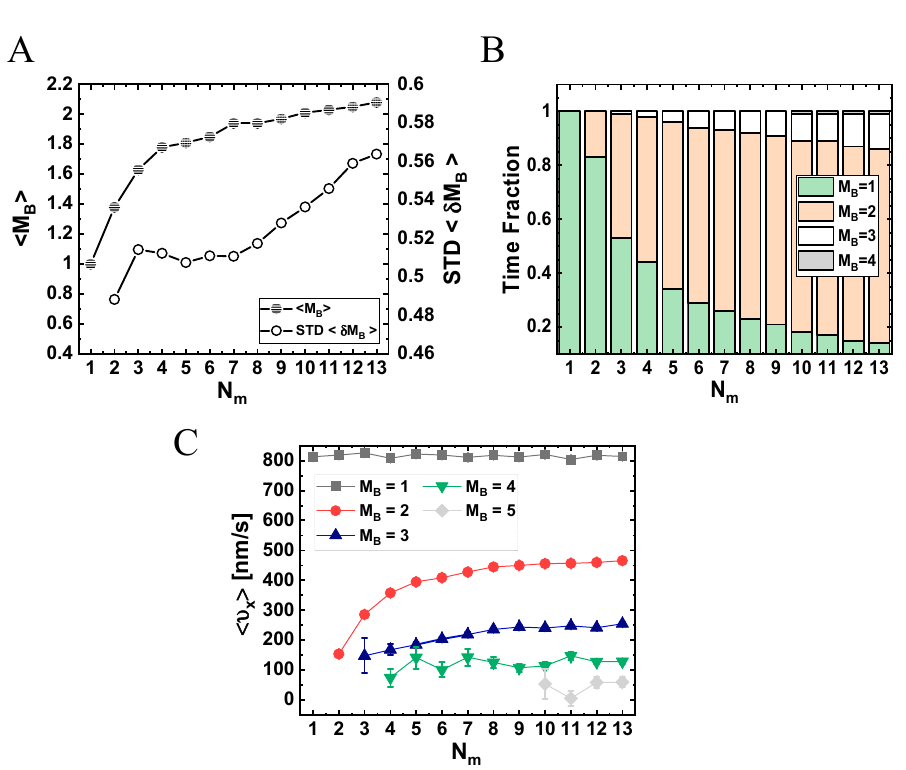
Figure 8. Participating (MT-bound) motors, M B , for different ( R = 20 nm, N m ) configurations and a time interval ∆ t = MC-step time. ( A ) Mean ( ± SEM) number of participating motors (cid:104) M B (cid:105) and STD against the number of NP-bound motors N m (data are shown in Table S11). ( B ) Fraction of time the NPs spend in each of the M B -states, for different values of N m (data are shown in Table S12). ( C ) Mean ( ± SEM ) longitudinal velocities of the different M B -states for different values of N m (data are shown in Table S13). Note that states of M B ≥ 5 are extremely rare for N m ≤ 13; therefore, in ( B ), the state M B = 5 is not shown and it appears only for N m ≥ 10 in ( C